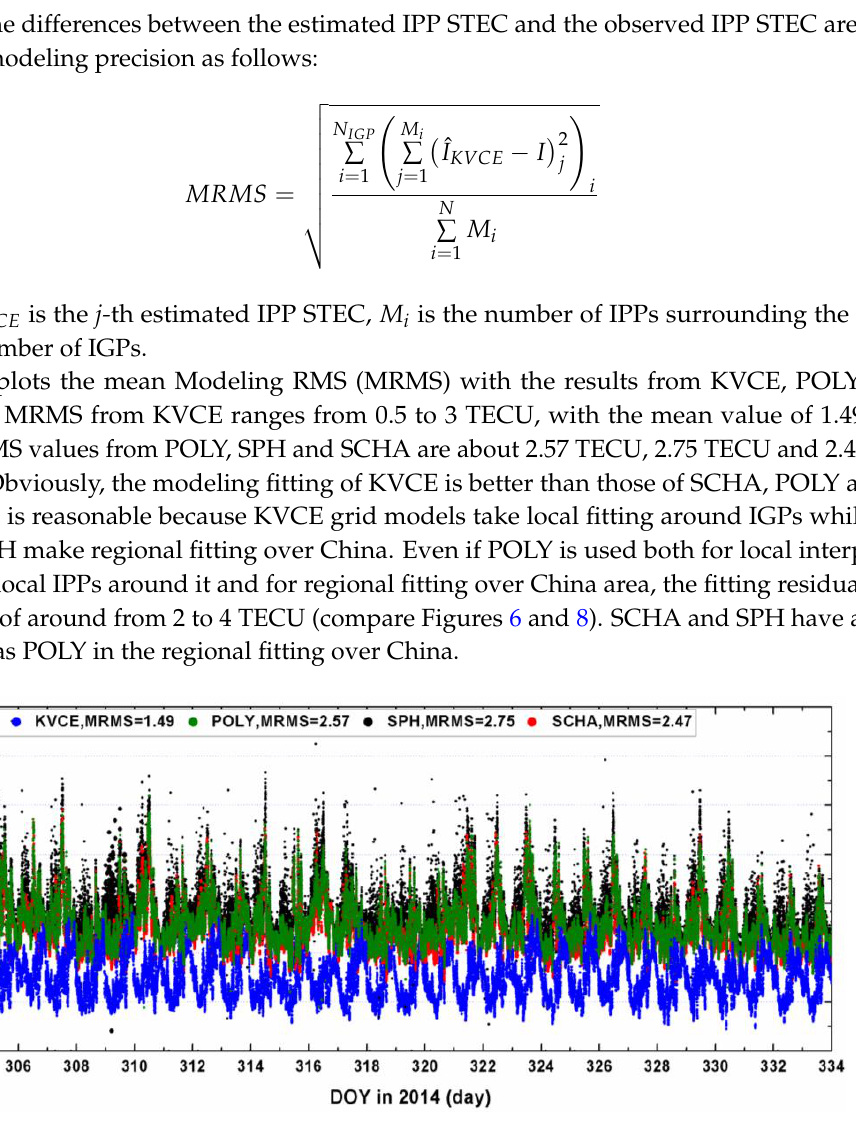
Figure 8. The MRMS of KVCE and TEC modelings with polynomial functions, spherical harmonic functions and spherical cap harmonic functions.